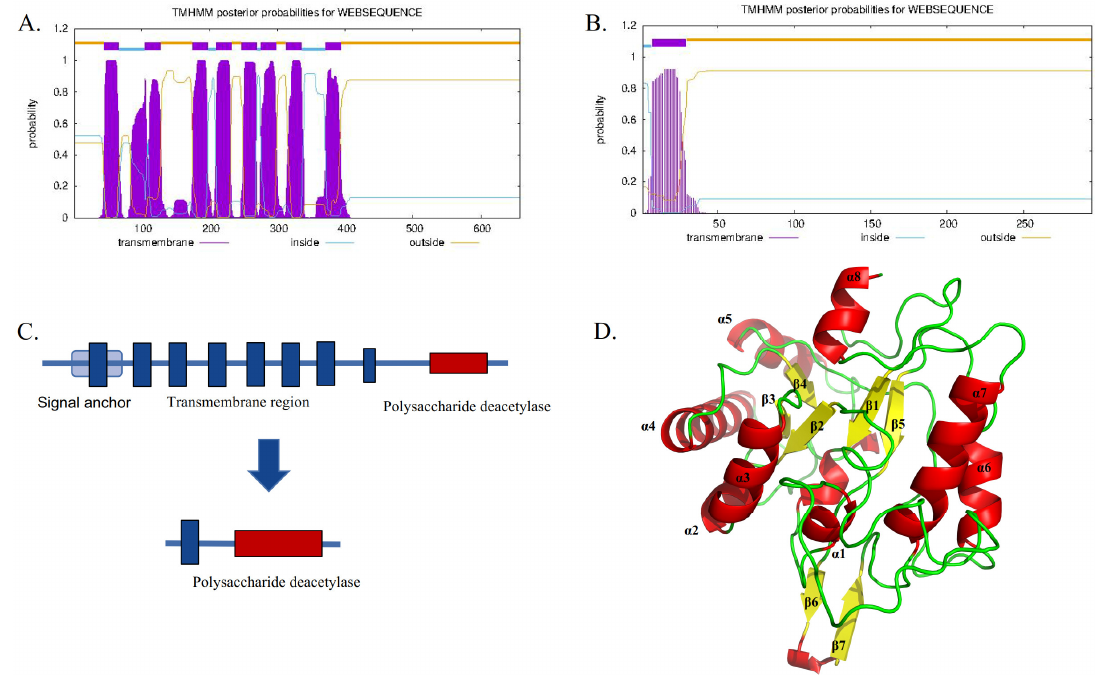
Figure 2. Sequence comparison between TwCDA and TwCDA-S. ( A ) TwCDA has 8 transmembrane helices at amino acids 44 to 393 and a signal anchor. ( B ) TwCDA-S has 1 transmembrane helix at amino acids 7 to 29. ( C ) Both TwCDA and TwCDA-S have a complete polysaccharide deacetylation motif at their C -terminal. ( D ) TwCDA’s tertiary structure. Stereo images of TwCDA and the canonical TIM barre ( α / β ) 8 fold as observed in